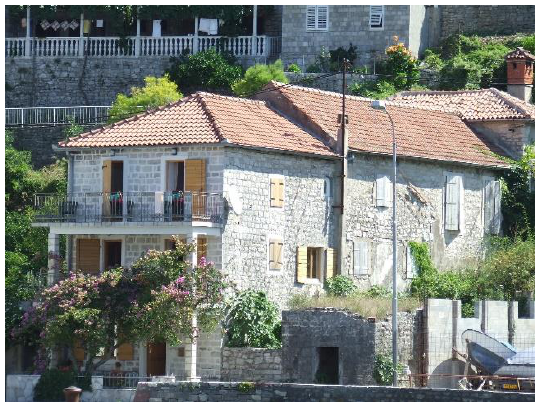
Figure 22. A house in Lepetani from the second half of the 19th century whose rehabilitation was carried out in the 1980s of the 20th